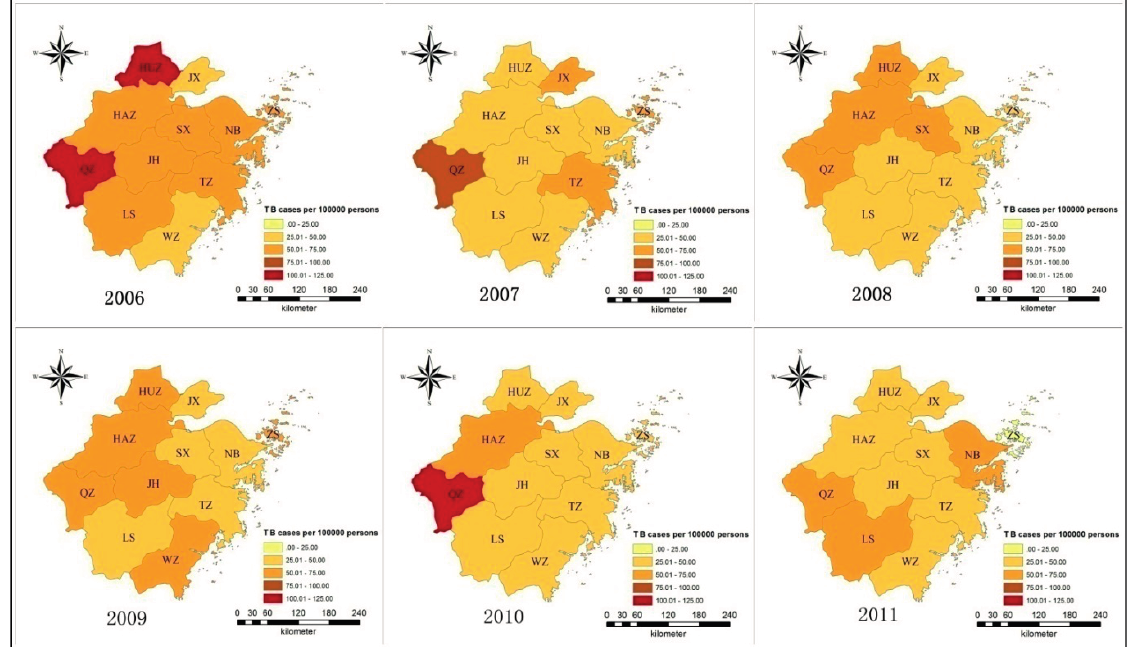
Figure 4. Tuberculosis (TB) notification rates of HCWs in 11 prefectures from 2006 to 2011 in Zhejiang (color depth indicating severity of epidemic at each 25/100,000 with the lightest level at 0–25/100,000 and the deepest at 100–125/100,000).